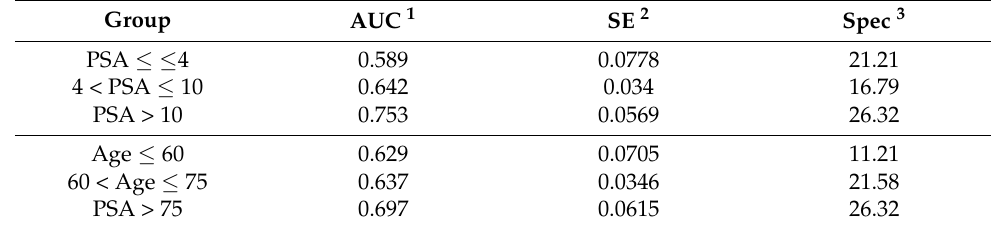
Table 5. Urinary zinc performance in patients’